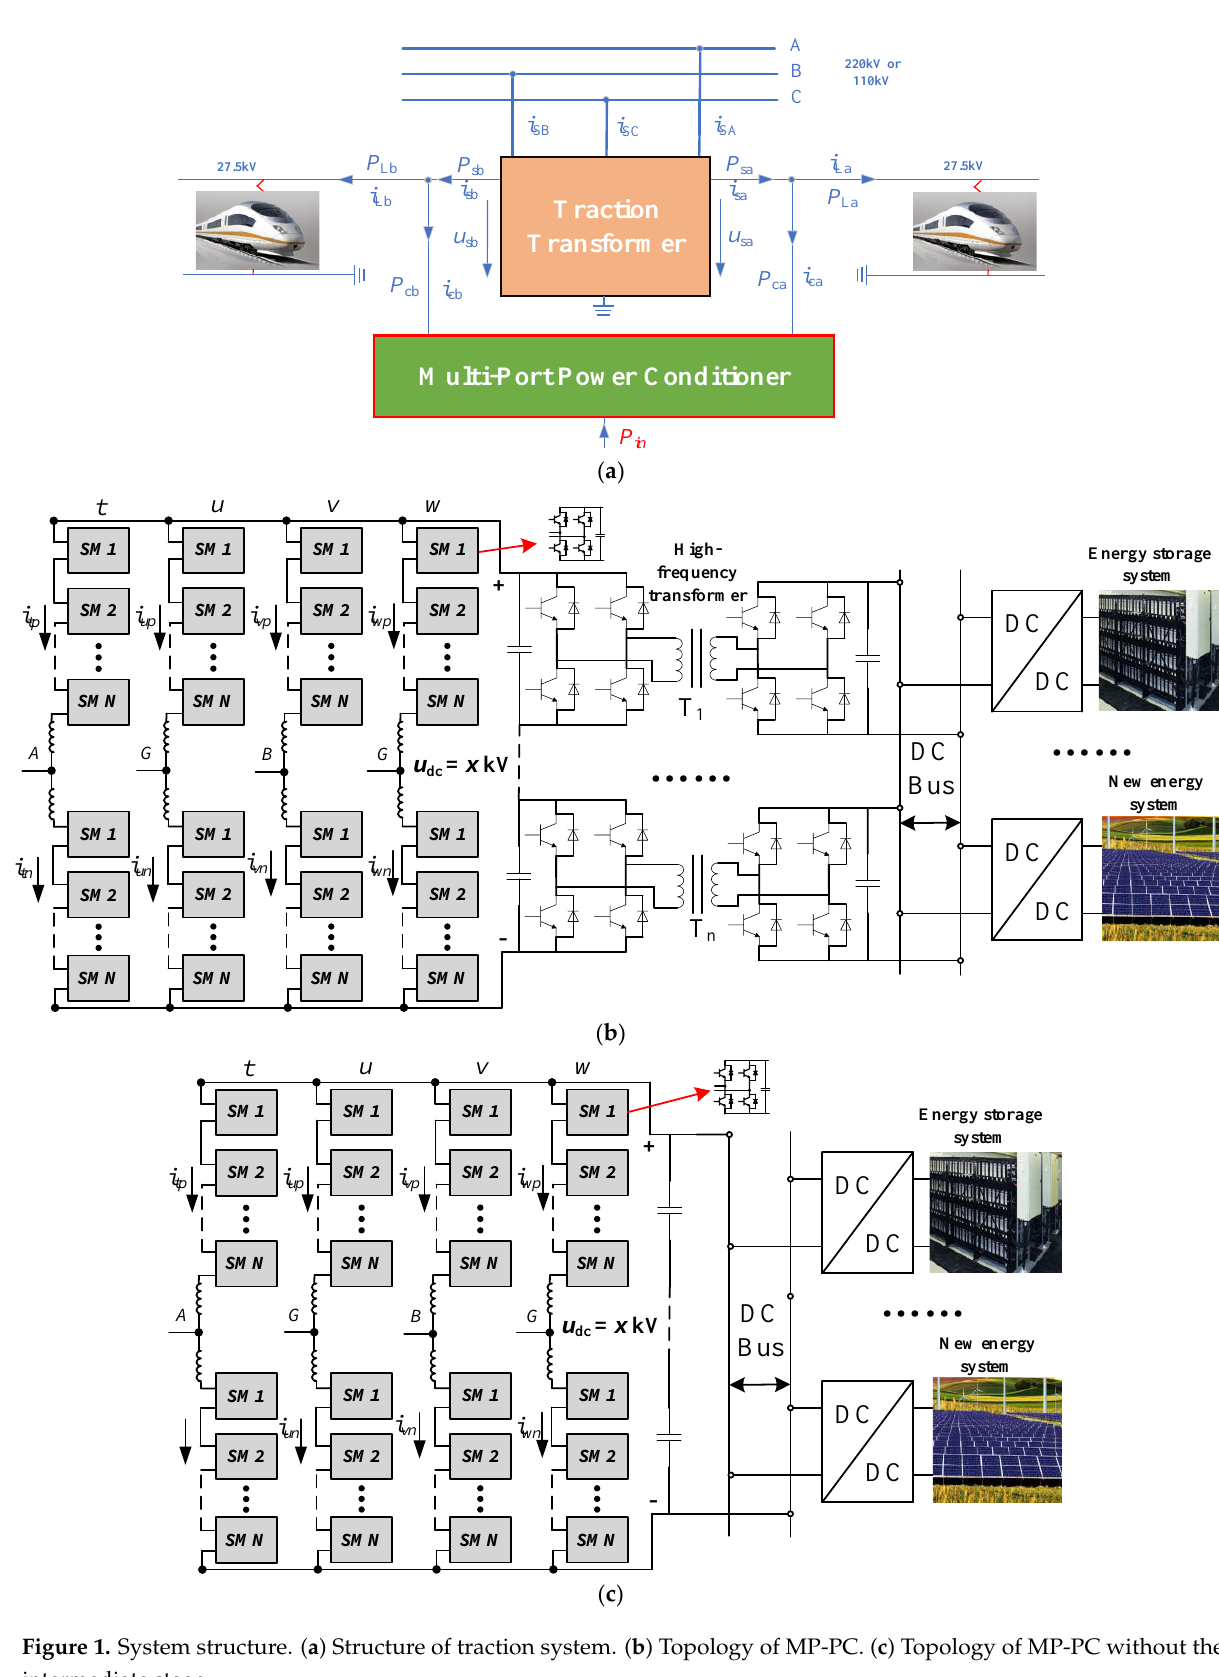
Figure 1. System structure. ( a ) Structure of traction system. ( b ) Topology of MP-PC. ( c ) Topology of MP-PC without the intermediate stage.